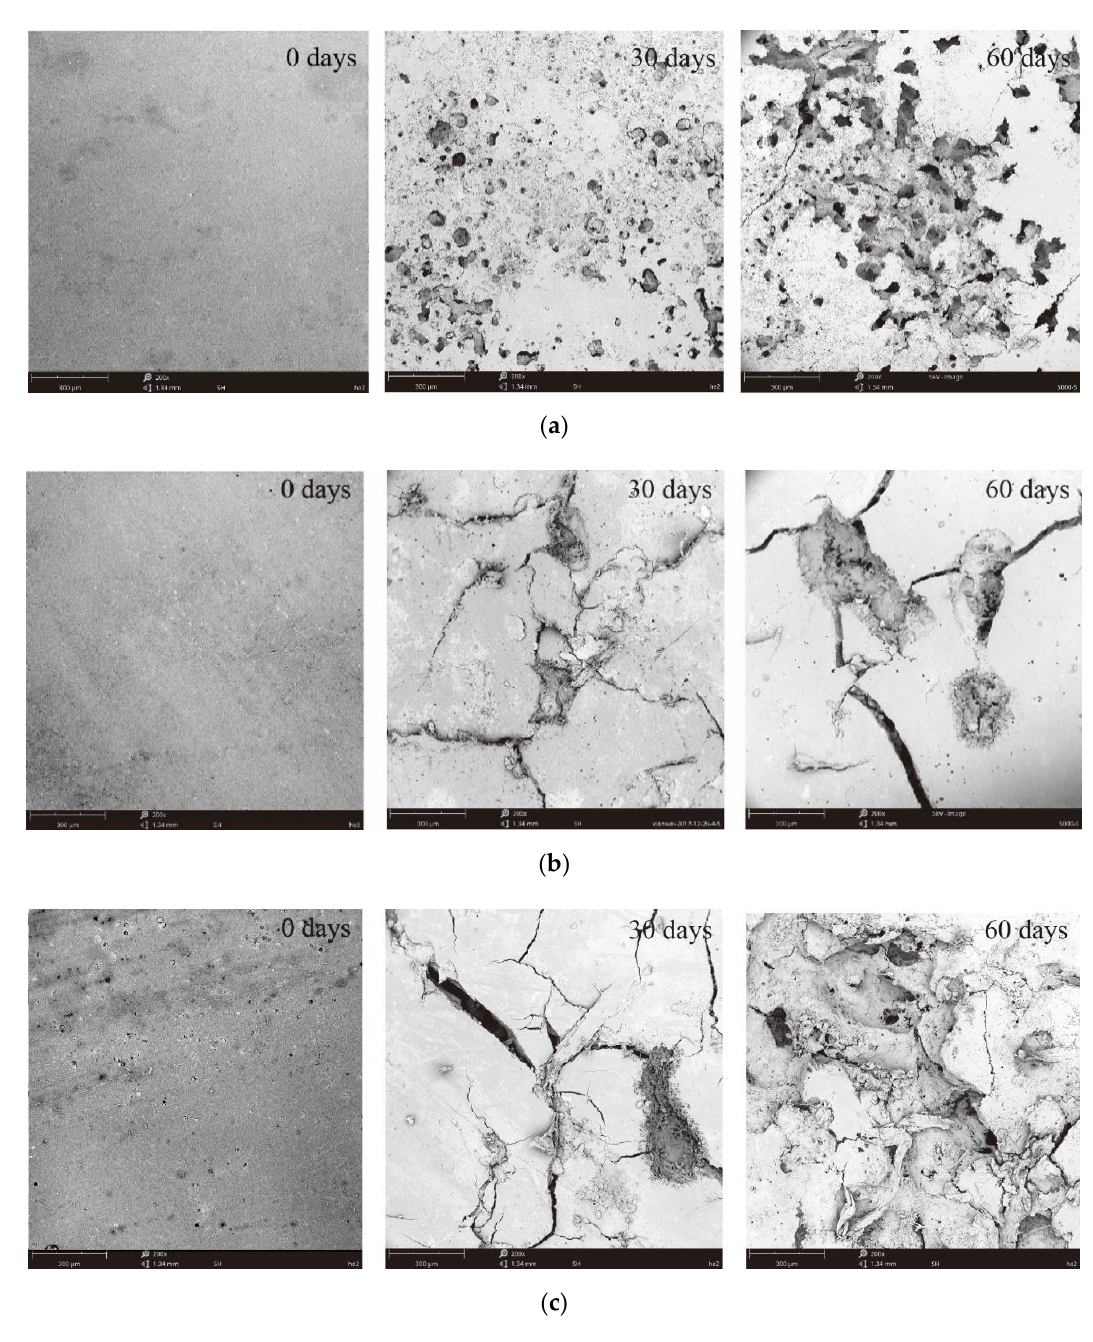
Figure 10. SEM images of ( a ) pure PBS, ( b ) 10% cassava residues/PBS composite and ( c ) 30% cassava residues/PBS composite after different disintegration times. ( a ) Pure PBS; ( b ) 10% cassava residues/PBS composite; ( c ) 30% cassava residues/PBS composite.